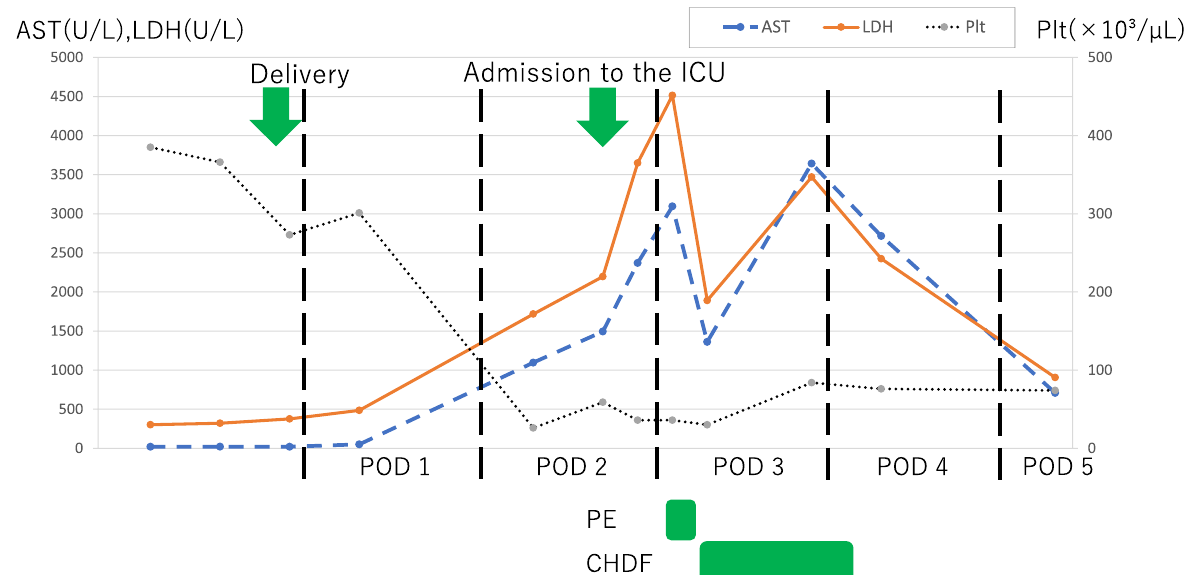
Fig. 1 Changes in laboratory findings and events. After delivery, acute elevations in AST and LDH and a rapid decrease in platelet count were observed and continued to worsen. PE therapy was performed, and the laboratory findings improved. AST, aspartate aminotransferase (IU/L); LDH, lactate dehydrogenase (IU/L); Plt, platelet count (/L); PE, plasma exchange; CHDF, continuous hemodiafiltration; POD, postoperative